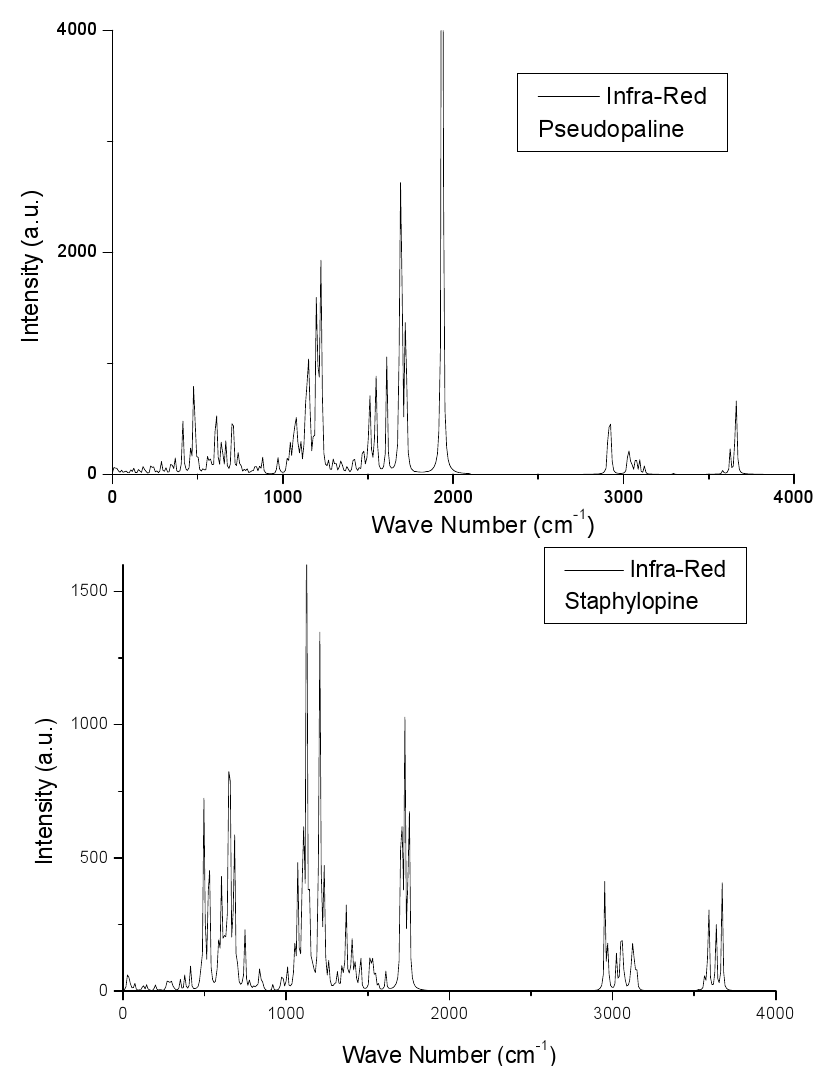
Figure 3. Infrared spectra of pseudopaline and staphylopine. Attributions are provided in Table 1.